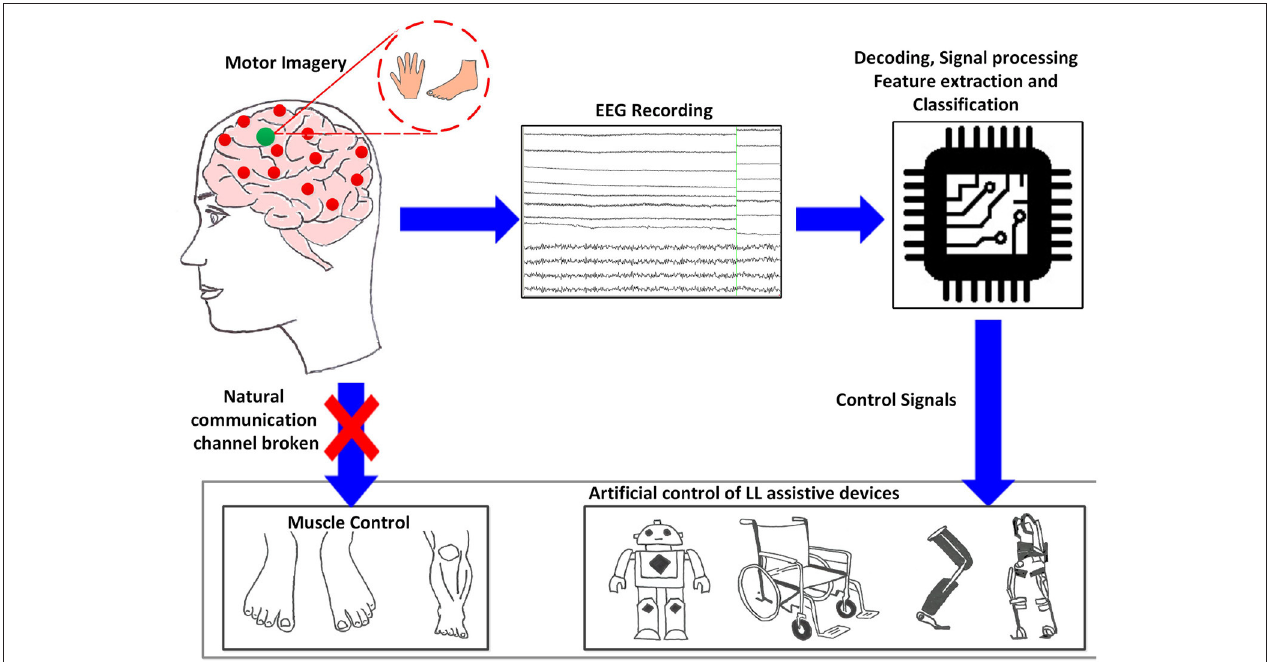
FIGURE 1 | Generic concept/function diagram of BCI controlled assistive LL devices based on motor